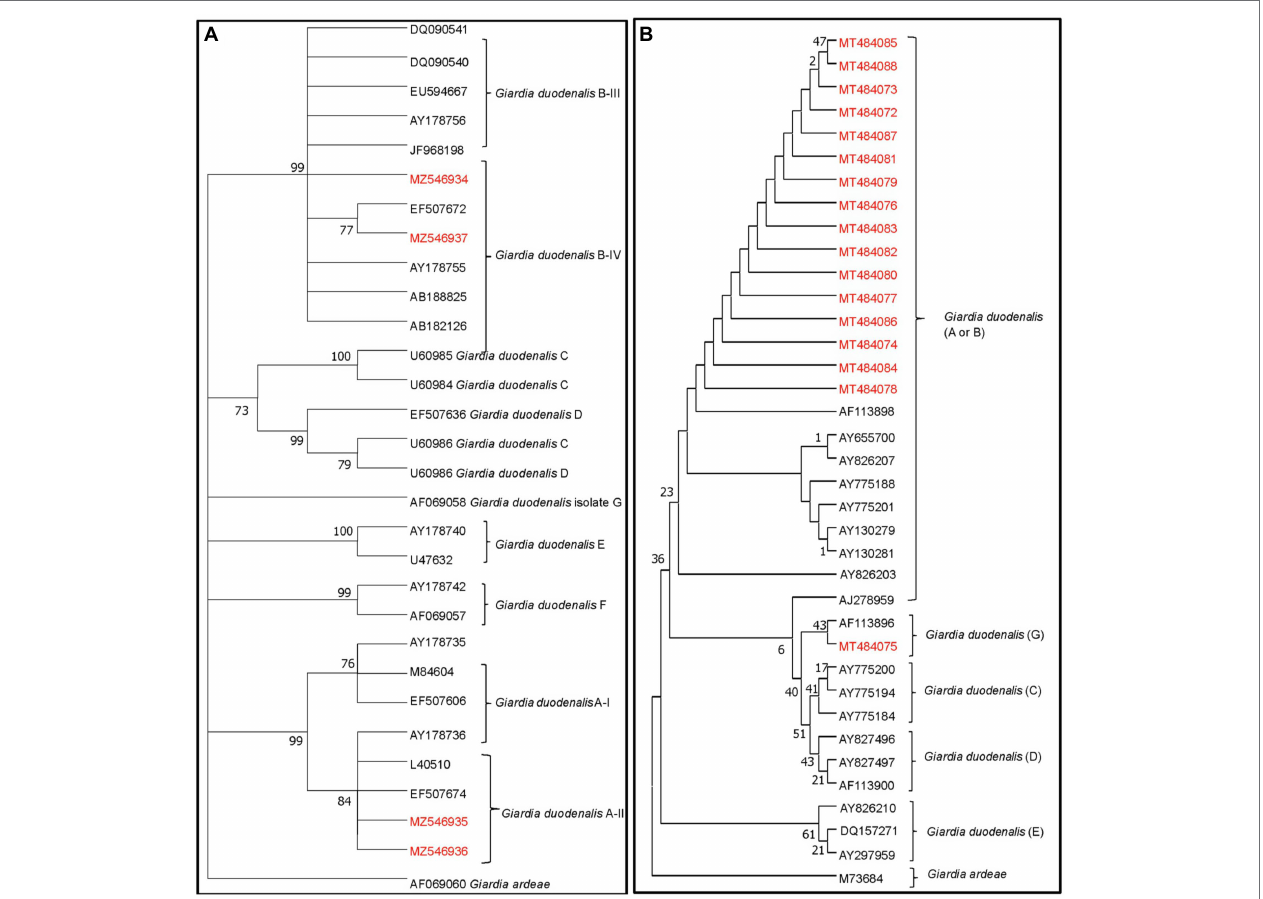
FIGURE 3 | Maximum likelihood phylogenetic analysis of G. duodenalis detected from river water samples. The analysis was constructed by using the Tamura 3 parameter model with MEGA 7.0 and the bootstrap values were calculated with 1,000 replicates. The analysis is based on (A) the GDH gene and (B) ssuRNA. The phylogenetic tree was rooted to G. ardeae . Depending on the assemblages of G. duodenalis determined by the different clades of the phylogenetic tree, the possible host source of fecal contamination could be inferred. The numbers at branch nodes represent bootstrap values greater than 70. Reference sequences included in the analysis are shown with their respective GenBank accession numbers. G. duodenalis strains characterized in this study are shown in red